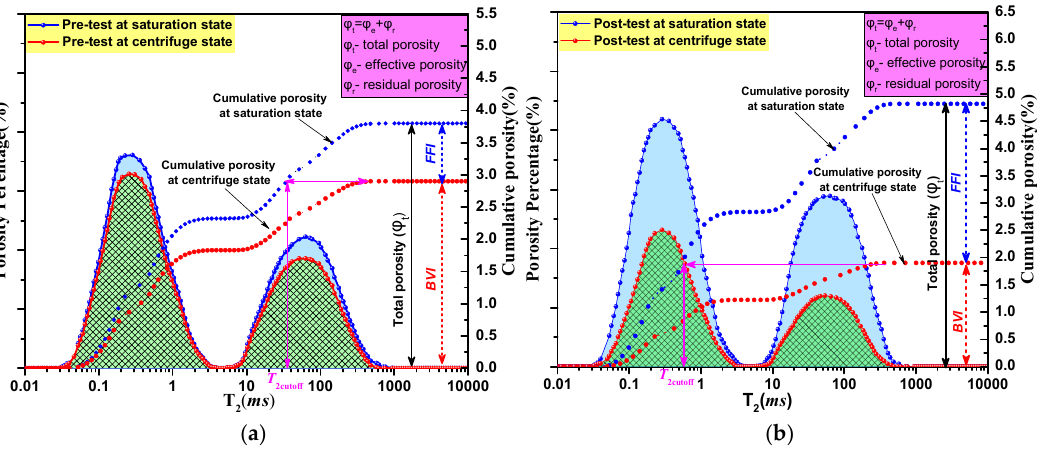
Figure 7. Schematic of the porosity percentage and cumulative porosity of 1/3 coking coal under water-saturated and irreducible water conditions: ( a ) Original state ( b ) P c = 60 min.